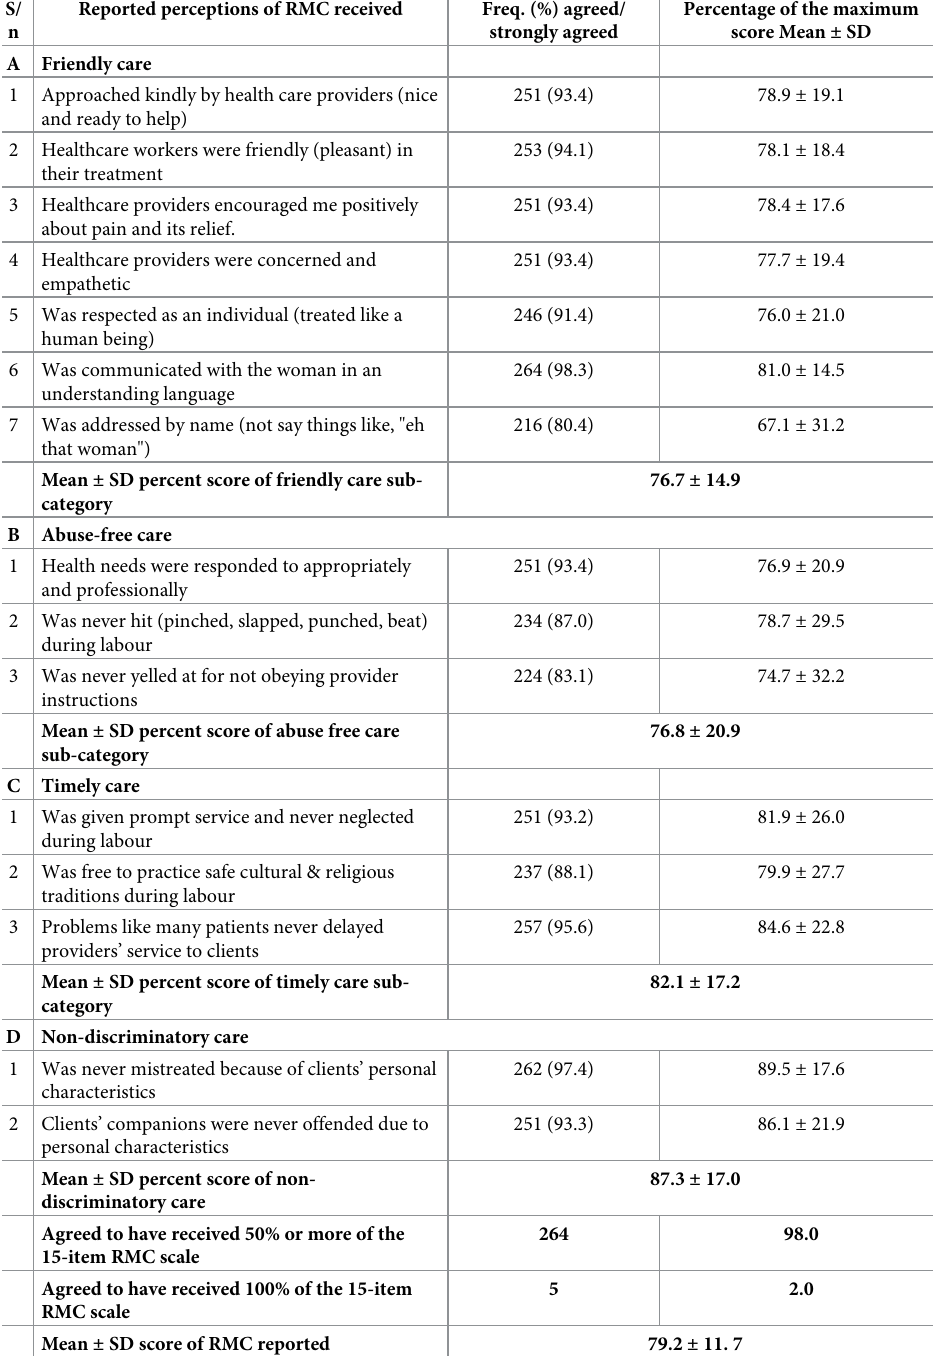
Table 5. Reported perceptions of RMC received during childbirth from post-partum interview (n =